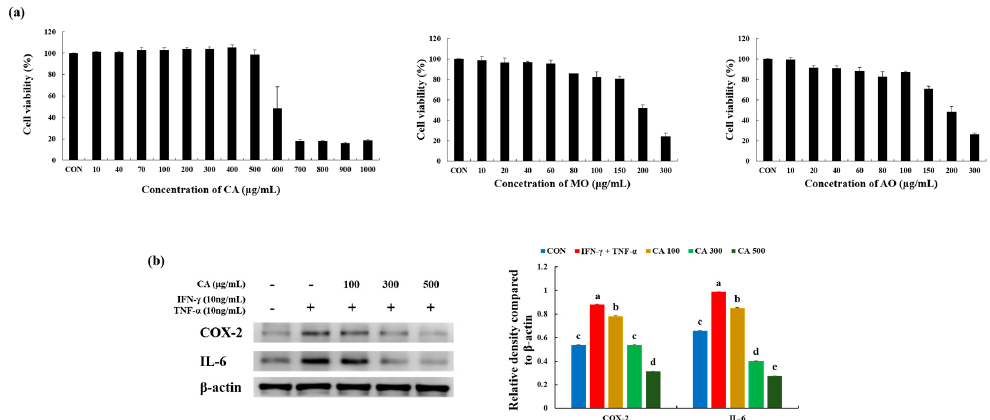
Figure 3. Polyphenol and flavonoid content, and antioxidant capacities of CA. ( a ) Total polyphenol and flavonoid; ( b ) 2,2'-azinobis-(3-ethylbenzothiazoline-6-sulfonic acid) (ABTS) and 2,2-diphenyl-1- picrylhydrazyl (DPPH) scavenging activity. Values represent the mean ± SD. Values with different letters were significantly different according to Duncan’s multiple range test ( p < 0.05). GAE: gallic acid equivalents, CHE: (+)-catechin hydrate